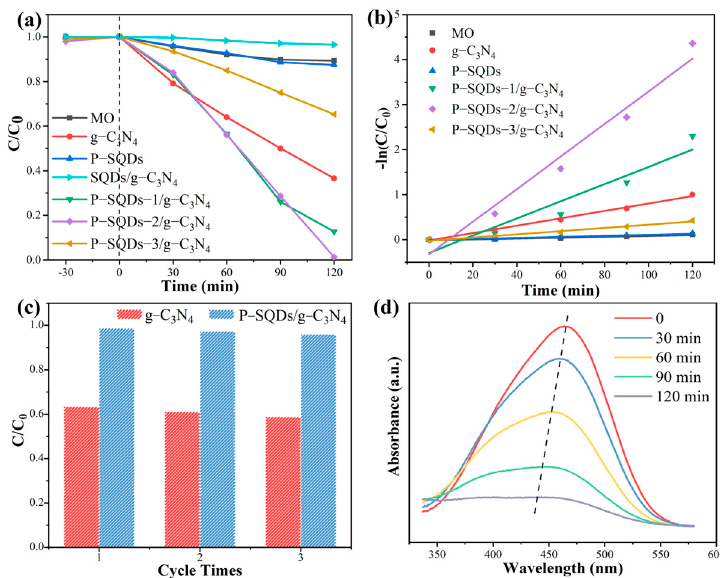
Figure 6. ( a ) Effect of different samples on the photocatalytic degradation of MO under visible light (Xe lamp). ( b ) The corresponding degradation kinetic behavior. ( c ) The photocatalytic cycle tests of g-C 3 N 4 and P-SQDs/g-C 3 N 4 . ( d ) UV–vis spectra of MO solution after P-SQDs/g-C 3 N 4 degra- dation with time.